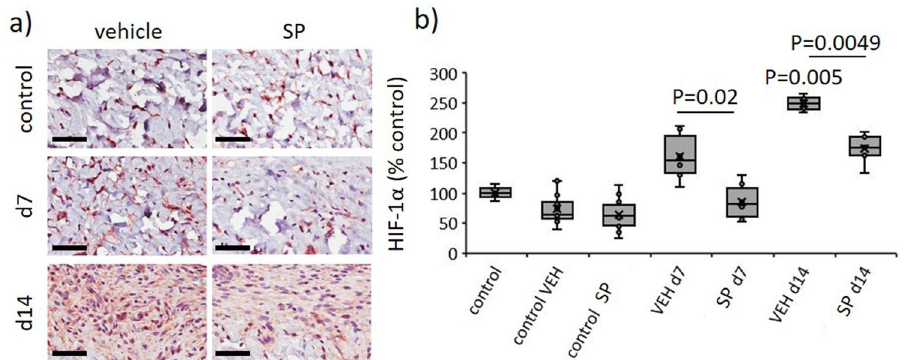
Figure 5. SP reduces hypoxia in response to I/R-mediated pressure injury. Representative images ( a ) and quantification ( b ) of HIF-1α in pressure injury wound tissue. Scale bar = 50 µm. HIF-1α data presented as percentage of vehicle-treated control, using box and whisker plot. Data were analyzed by two-way ANOVA with Bonferonni post-hoc